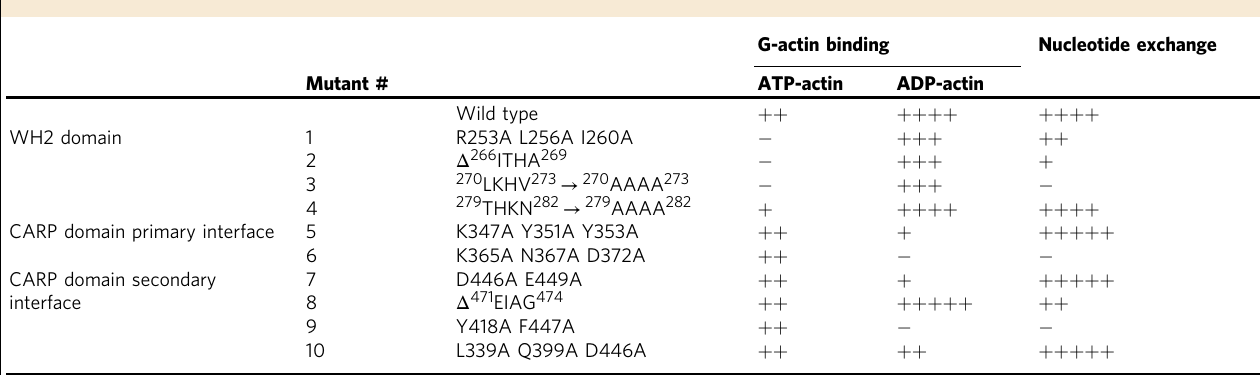
Table 1 Biochemical analysis of CAP1